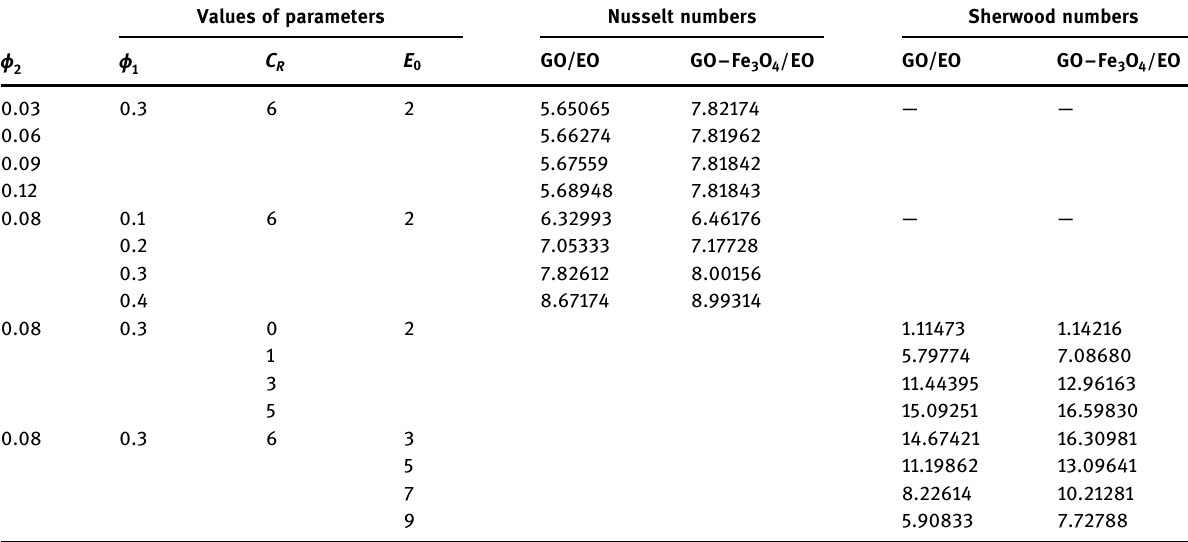
Table 6. The surface drag values of magnetic Prandtl number and induced magnetic fi eld parameter β increase, respectively ( Table 6 ) . Both 0 these parameters act parallel to each other in case of their e ff ects on shear rates and heat transfer rates. A signi fi cant change in the values of Nusselt number is noticed with the e ff ect of suction parameter whereas the other parameters have low e ff ect on